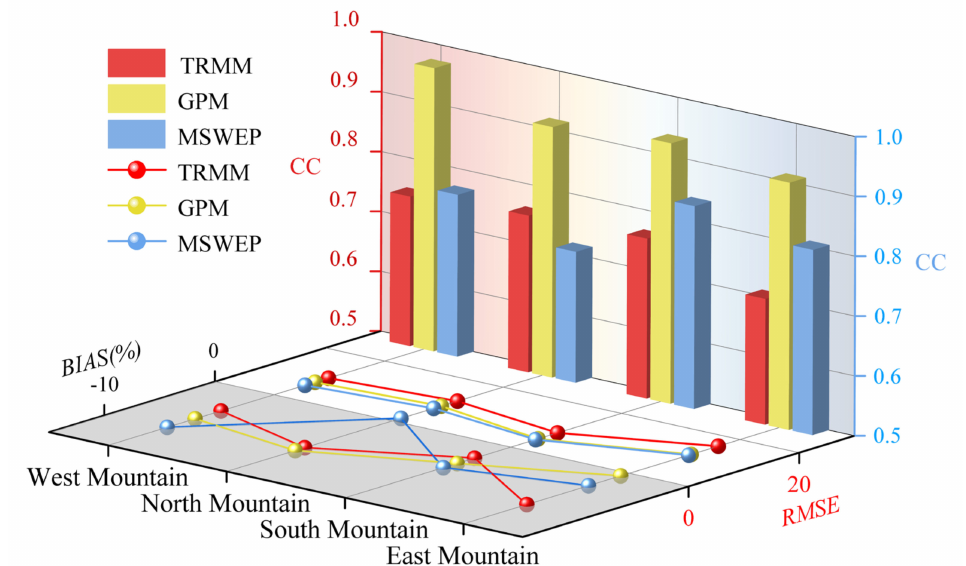
Figure 3. Comprehensive analysis of CC, BIAS and RMSE for monthly scale evaluation of precipita- tion